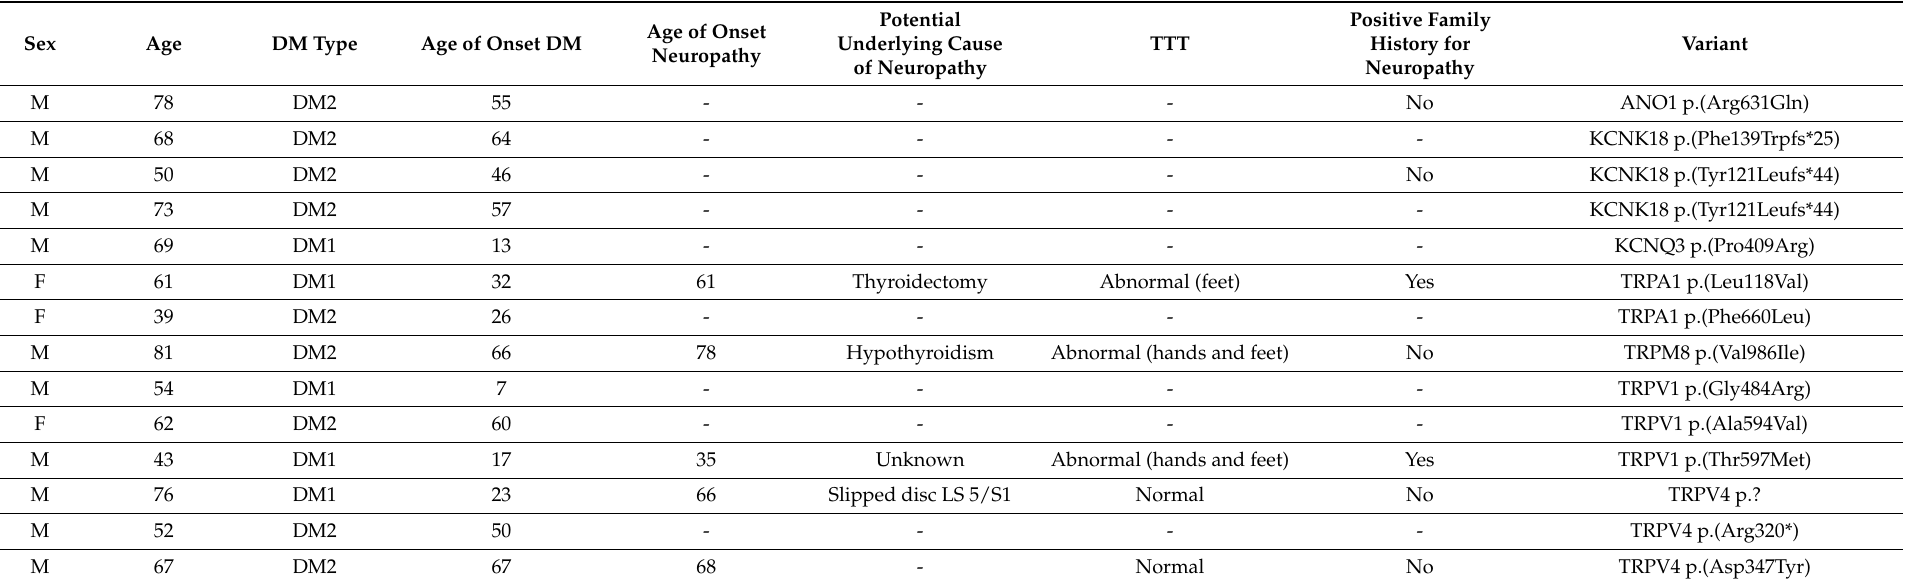
Table 4. Clinical characteristic of patients with painless-diabetic neuropathy and ion channel gene